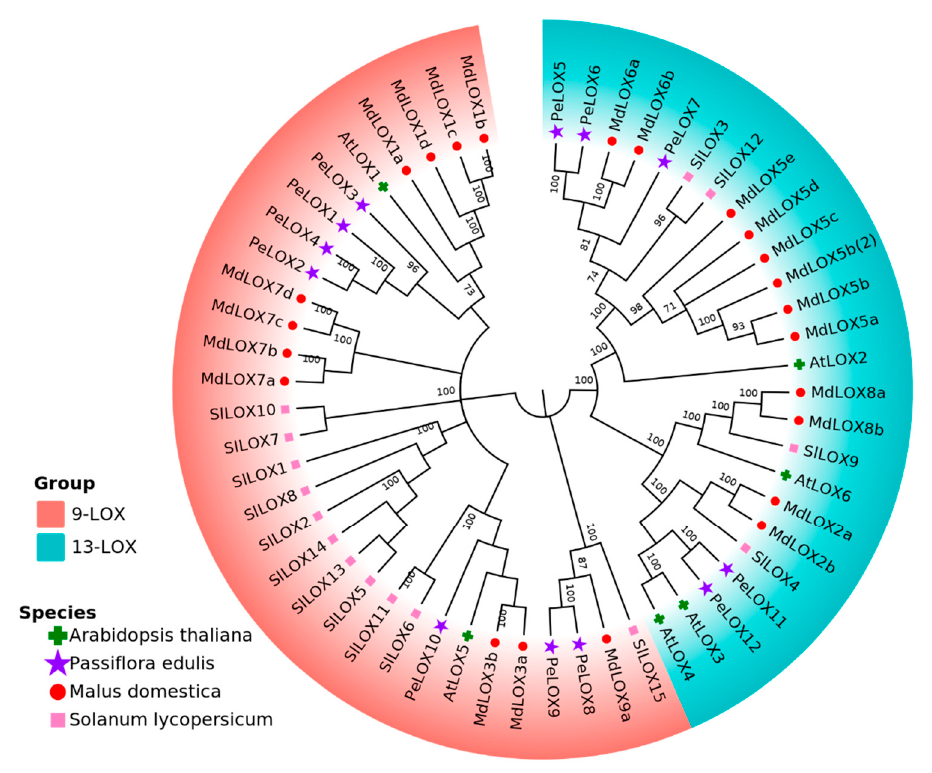
Figure 2. Phylogenetic tree for the protein for the LOX gene family in passion fruit, Arabidopsis thaliana , apples, and tomato.